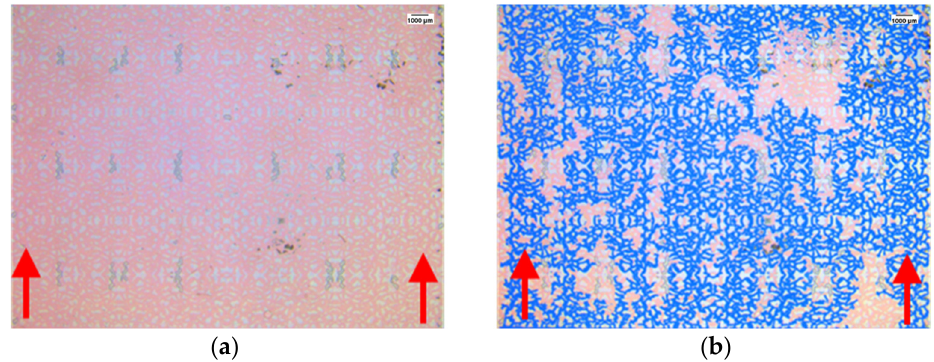
Figure 5. The microscopic image of the homogeneous model water flooding process. ( a ) Saturated oil and ( b ) end of water flooding.